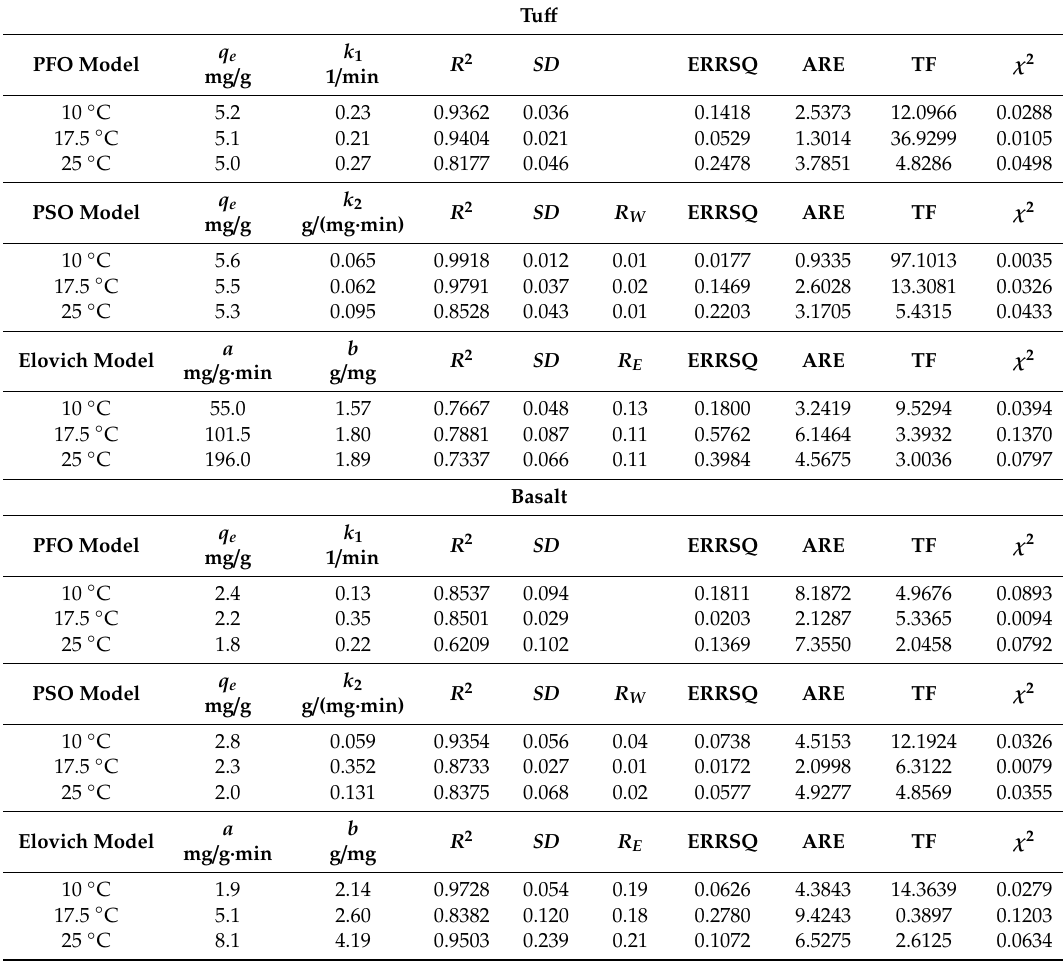
Table 4. Parameters of sorption kinetics models based on reaction order, characterized by coe ffi cient of determination, standard deviation and the error